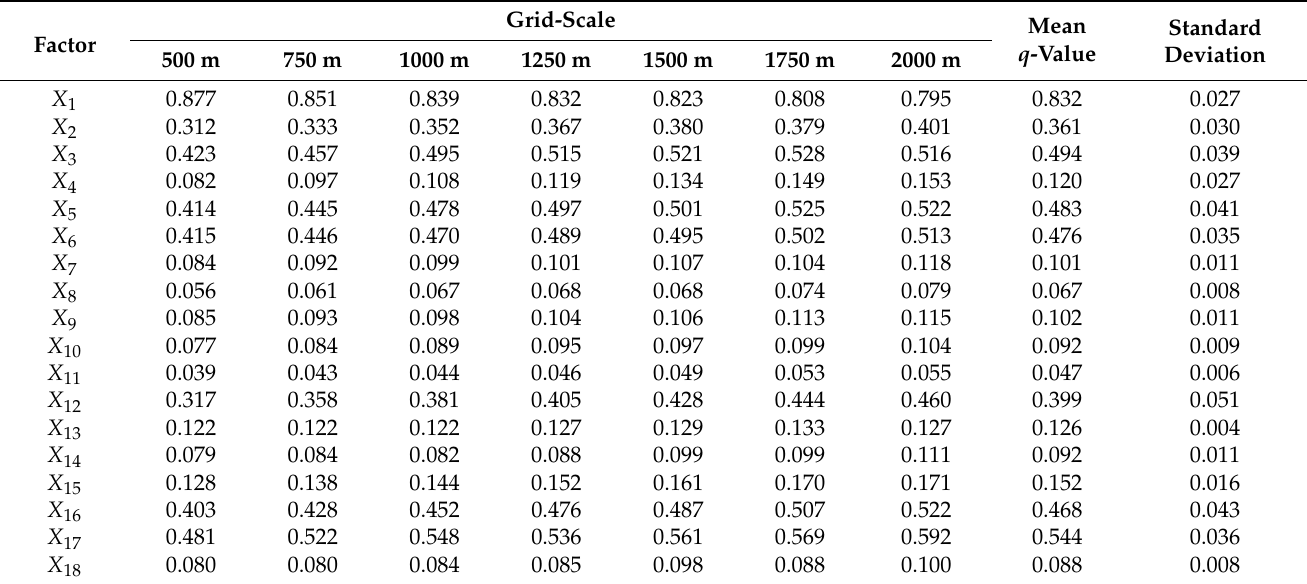
Table 3. q -value of factors at different grid-scales.